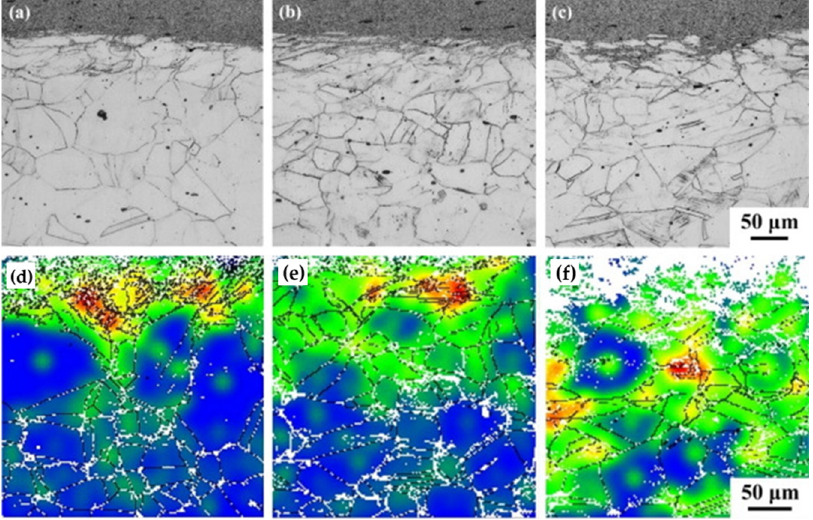
Figure 9. The transfer of transient zones to coarse grain zones of FSP high nitrogen stainless steel at tensile strains ( a , d ) 5%, ( b , e ) 10%, and ( c , f ) 20%. This figure was reprinted with permission of Zhang et al., 2019 [67].